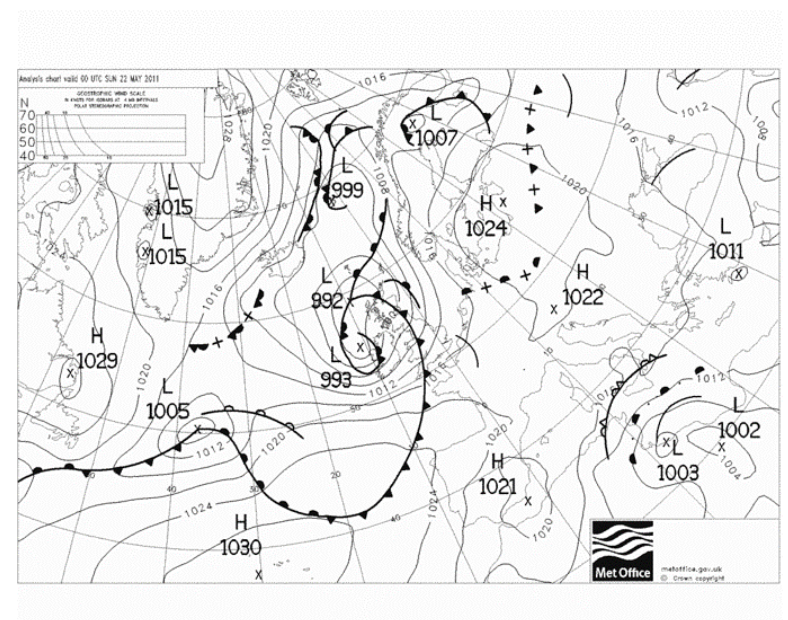
Figure 2. UK Met Office surface analysis chart at 0000 UTC on 22 May 2011. Mean sea level pressure isobars overlaid with active surface fronts (solid black lines with filled symbols), decaying surface fronts (crosses with filled symbols) upper-level fronts (solid black lines with unfilled symbols) and upper-level troughs (solid black lines).